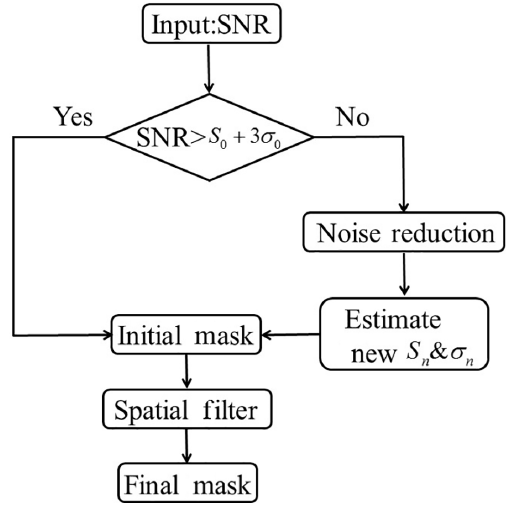
Figure 3. Schematic flow diagram for hydrometeor detection method. S o and S n are the mean SNR for the original and reduced noise,